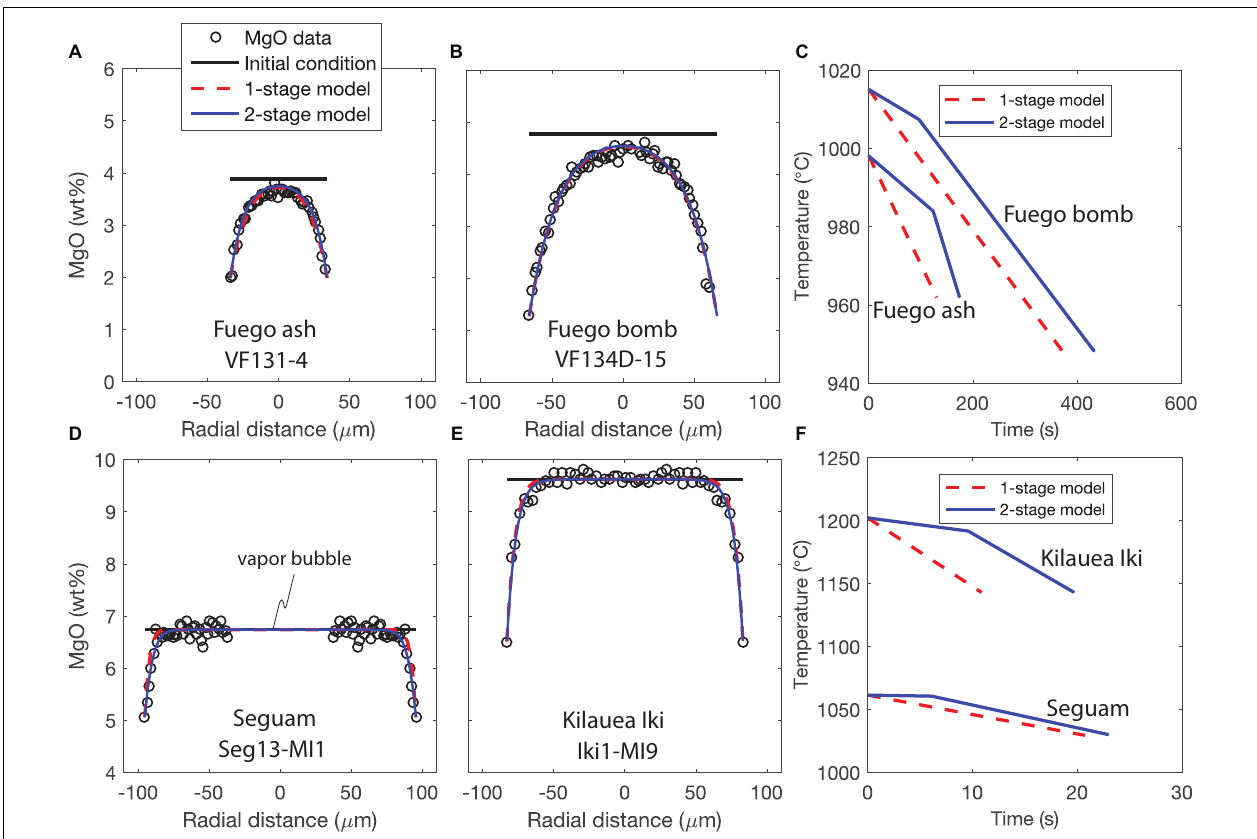
FIGURE 4 | Results of thermal history fitting to MgO concentration gradients in melt inclusions using the model of Newcombe et al. (2014), modified as described in section “Constraint of Syneruptive Thermal Histories Using MgO Zonation in Olivine-Hosted Melt Inclusions.” One representative melt inclusion is shown for Fuego ash and volcanic bombs, Seguam, and Kilauea Iki. Data and model fits for all melt inclusions are provided in the Supplement. MgO data from each inclusion have been fit to both one- and two-stage linear thermal histories. MgO data and best-fit thermal history model curves for (A) Fuego ash inclusion VF131-4, (B) Fuego bomb inclusion VF134D-15, (D) Seguam inclusion Seg13-MI1, and (E) Kilauea inclusion Iki1-MI9. Best-fit one- and two-stage thermal histories for (C) Fuego inclusions VF131-4 and VF134D-15 and (F) Seg13-MI1 and Iki1-MI9. Note difficult scales for (C,F)